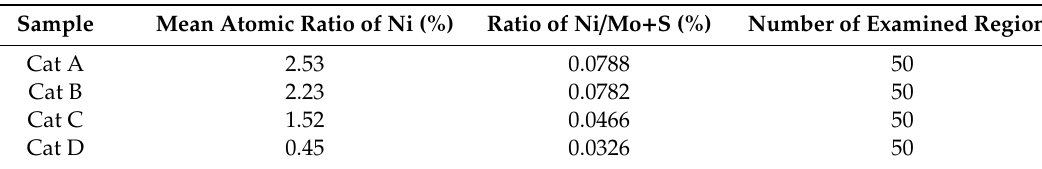
Figure 3. ( a ) Two district types on Cs-STEM-HAADF image of fresh NiMo/ γ -Al 2 O 3 catalyst (Cat A), and ( b , c ) corresponding energy dispersive X-ray spectroscopy (EDS) spectra. Table 2. Statistical data from the EDS results on Type I regions.